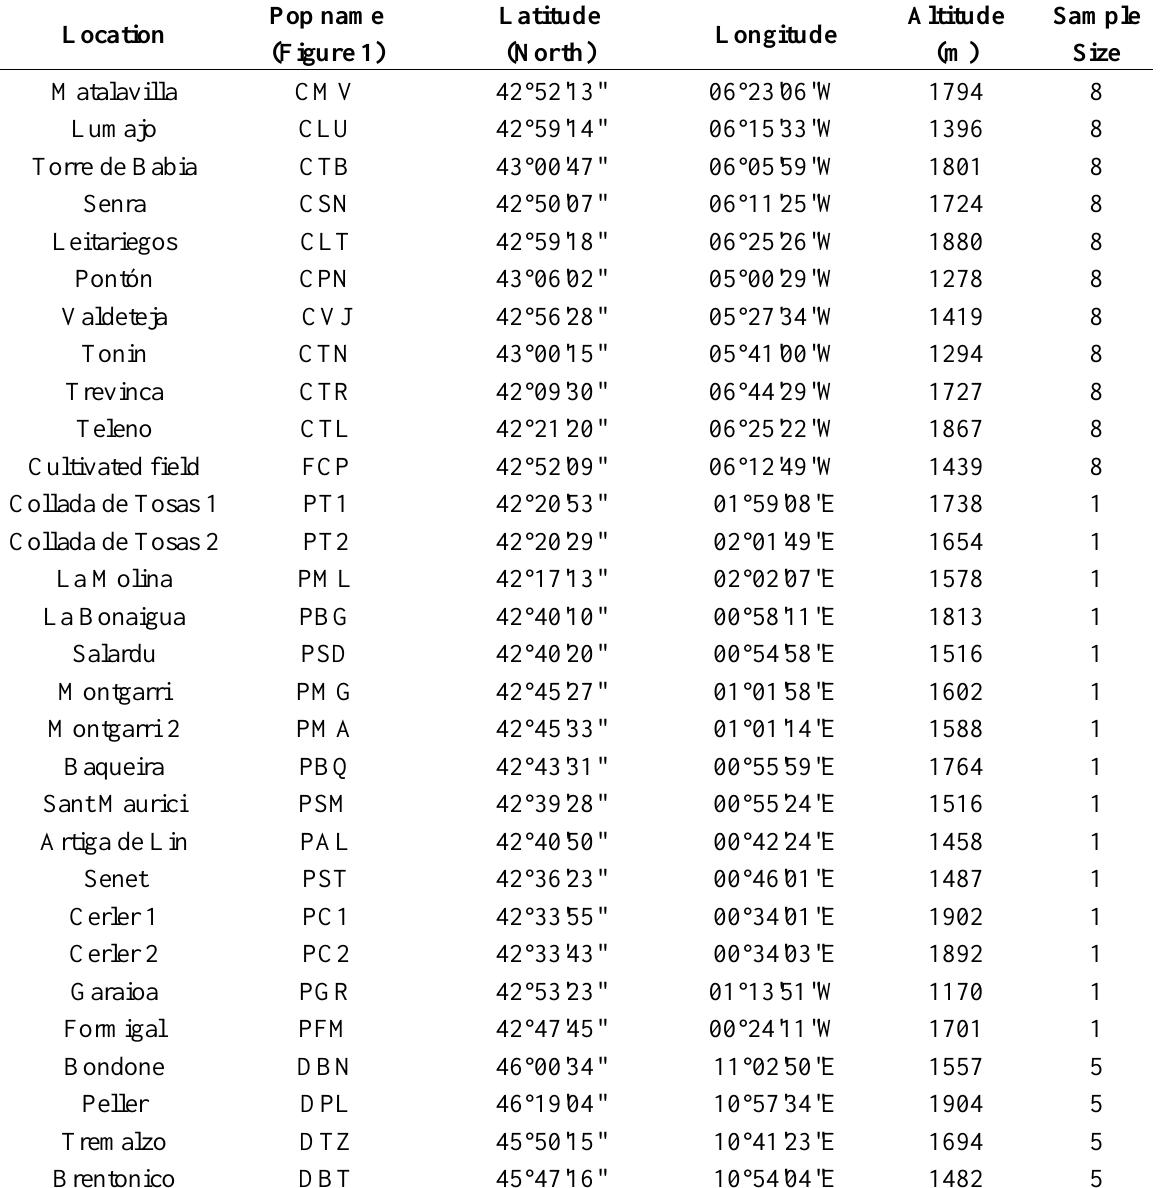
Table 3. Populations of G. lutea